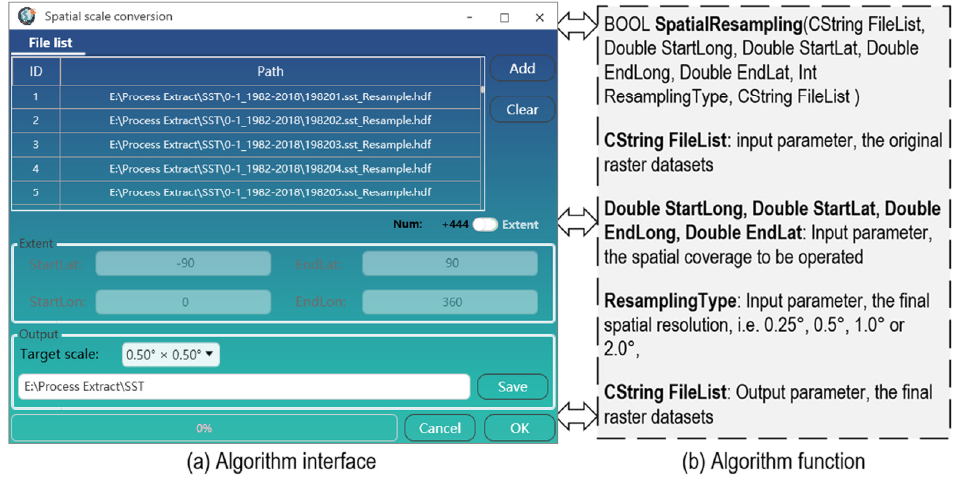
Figure 4. Example of spatial resampling algorithm function and interface.